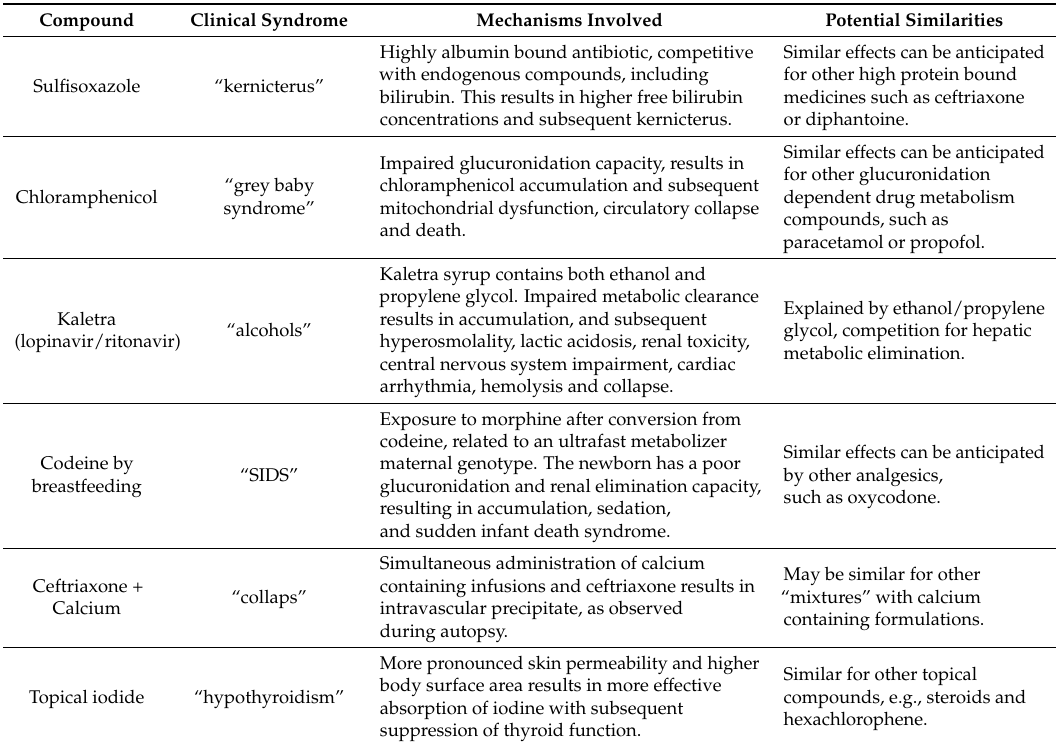
Illustrations of clinical relevant adverse drug reactions in neonates, with the mechanisms